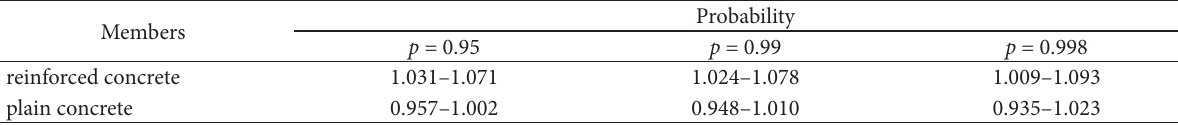
Table 3. The confidence interval of the relative mean value ( r m ) * according to the Student t -test